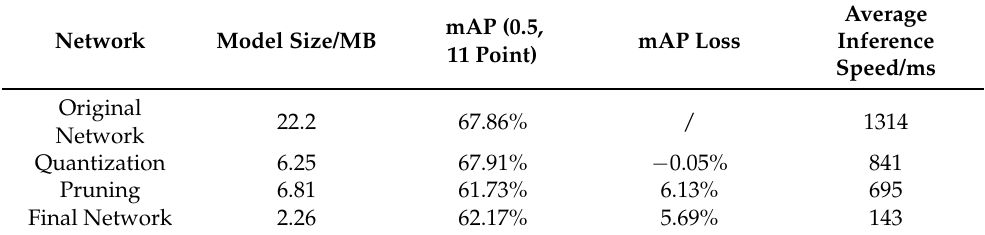
Table 5. Mobile Platform Test